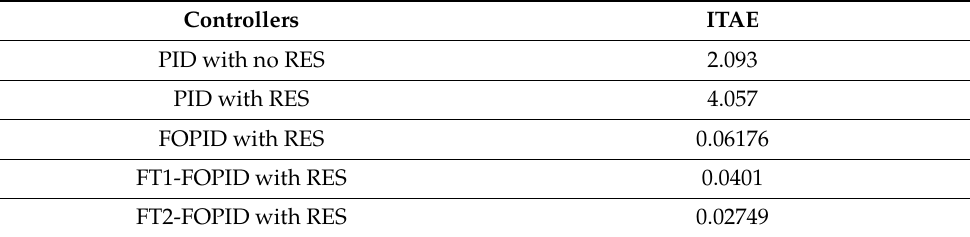
Table 5. ITAE results obtained for various controllers for demand change of 1% in Area 1 and 2% in Area 2.